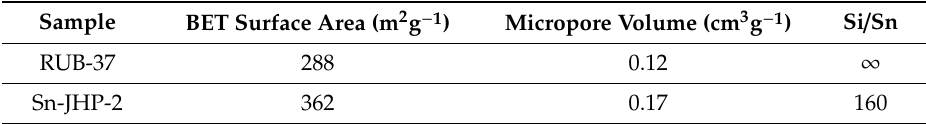
Figure 2. XRD patterns of ( a ) RUB-36, ( b ) RUB-37, ( c ) Sn-JHP-1 and ( d ) Sn-JHP-2.